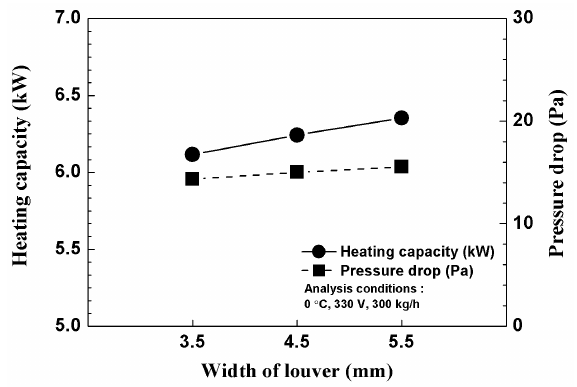
Figure 6. Heating capacity and pressure drop variations for different widths of the modified louver.